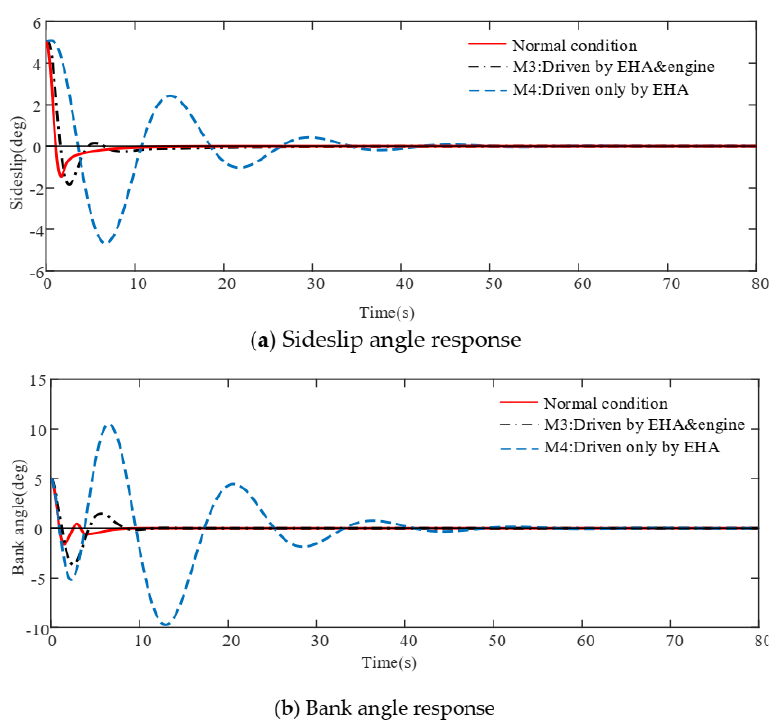
Figure 12. Recovery performance of damaged aircraft in scenario II under